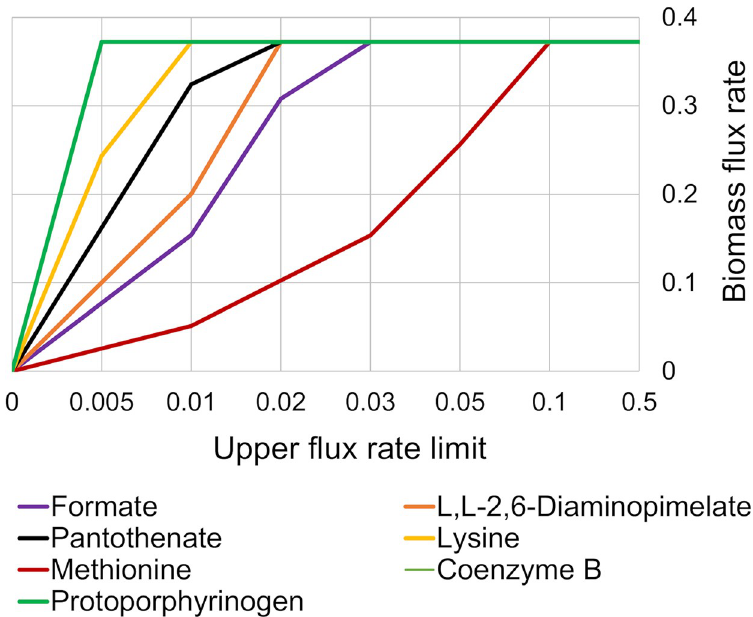
Fig 1. Influence of opening transport gates for essential in silico medium supplements on predicted biomass production for the M . leprae GSMN model. Media component uptake was limited to maximal value of 1 mmol g - 1 dryweight h -1 . The biomass flux rate for GSMN-ML was calculated with respect to the media components.